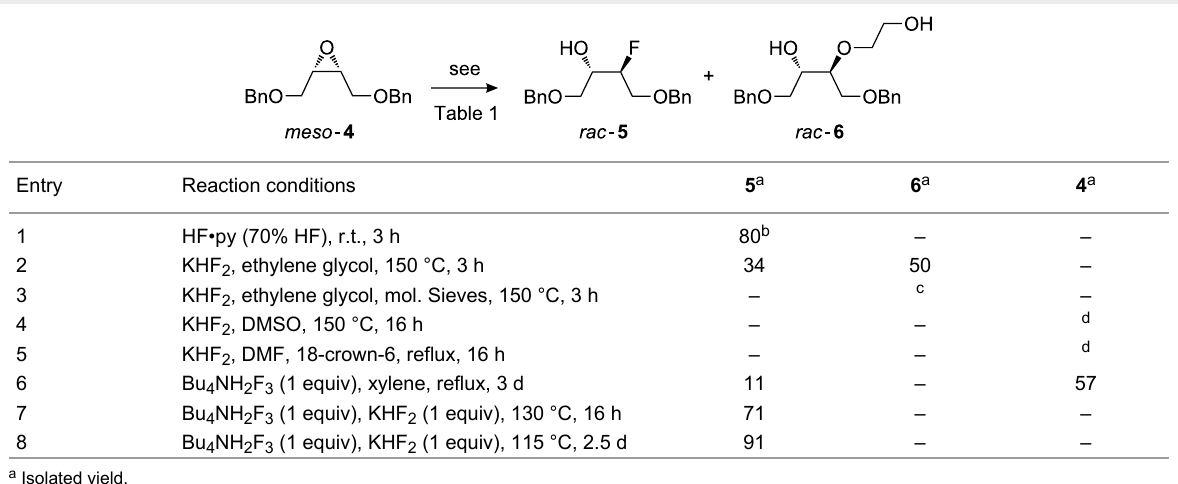
Table 1: Conversion of epoxide 4 to the fluorohydrin.